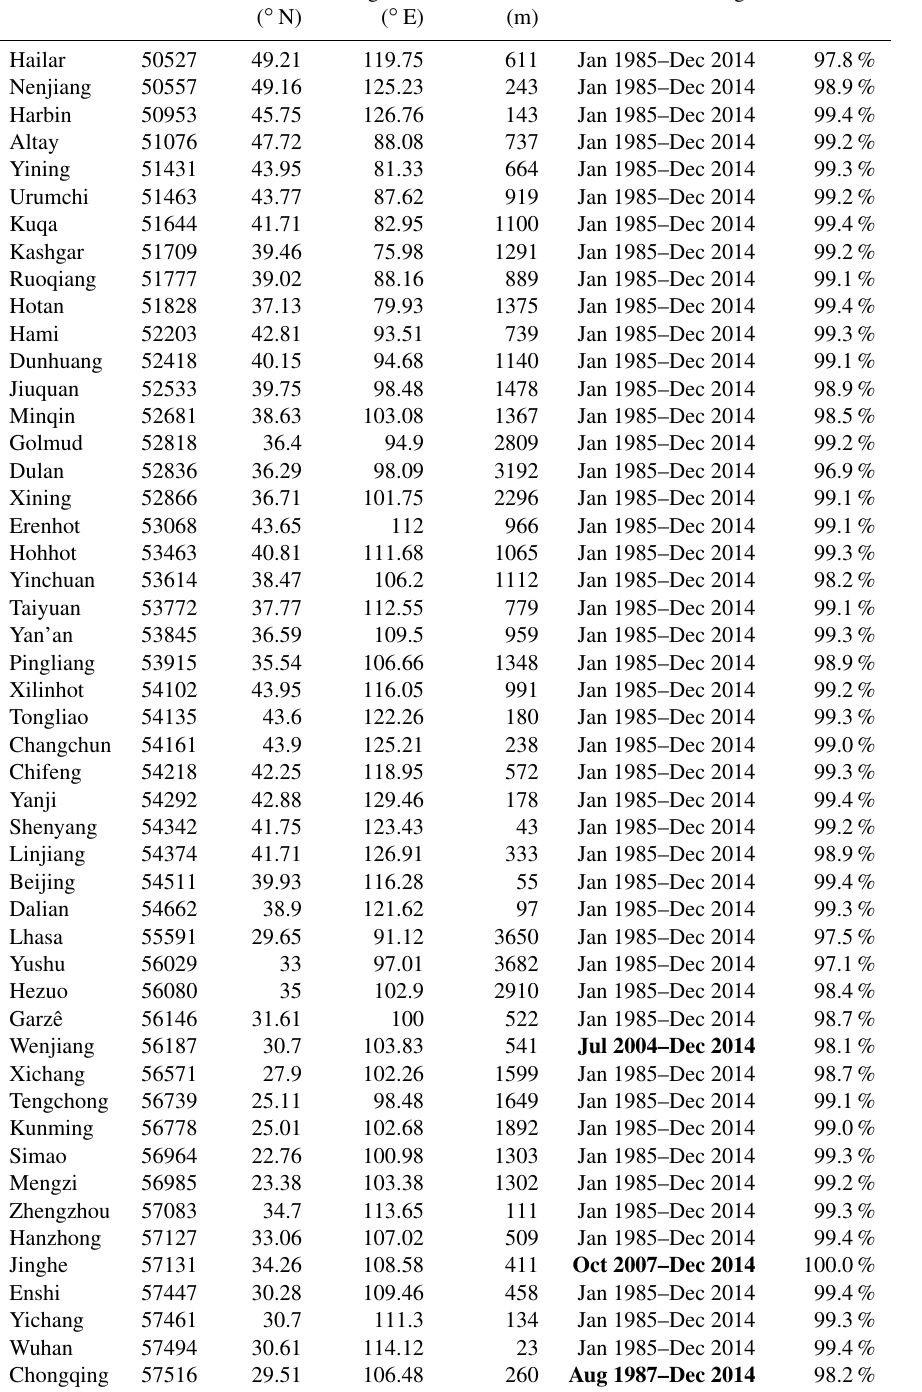
Table A1. The 66 radiosonde stations that have corresponding surface datasets from the CMA. The periods for which radiosonde and surface datasets were both available are summarized with the start and end dates in the column date range. Data periods of less than 30 years are highlighted in bold. The percentages of valid data are also presented